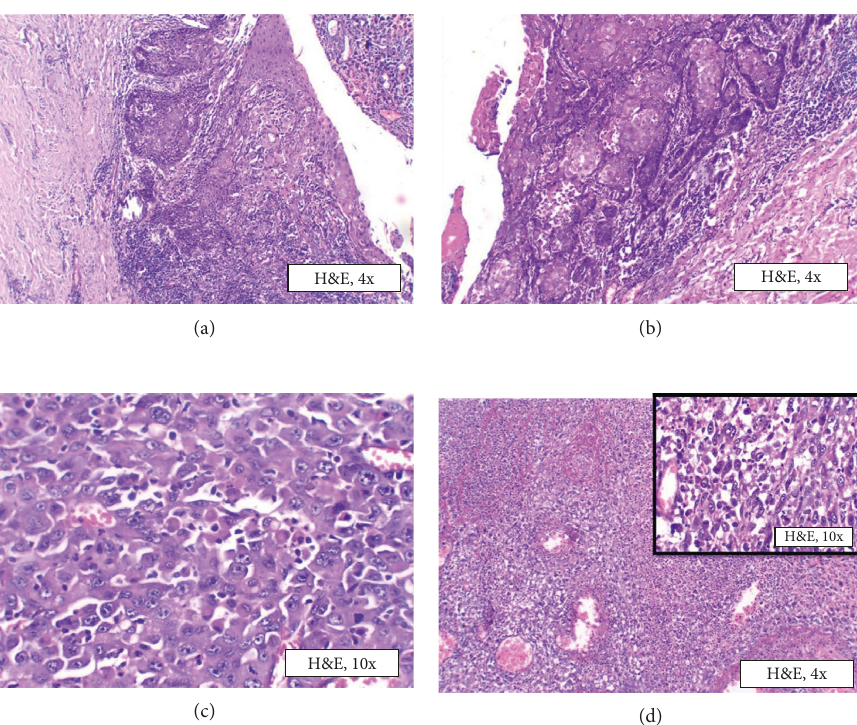
Figure 7: Excisional biopsy. Photomicrograph of excisional biopsy showing (a, b) dysplastic epithelium proliferating into connective tissue, 4x H&E; (c) pleomorphic cells with vesicular nucleus, rhabdoid appearance, 10x H&E; (d) sheets of biphasic tumor cells with spindle cells in inset, 10x